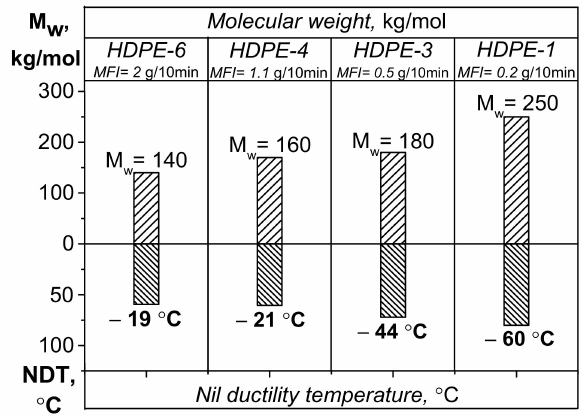
Figure 4. The diagram showing the dependence between the calculated parameter “nil ductility temperature (NDT)” [19] and M w for the bimodal HDPE